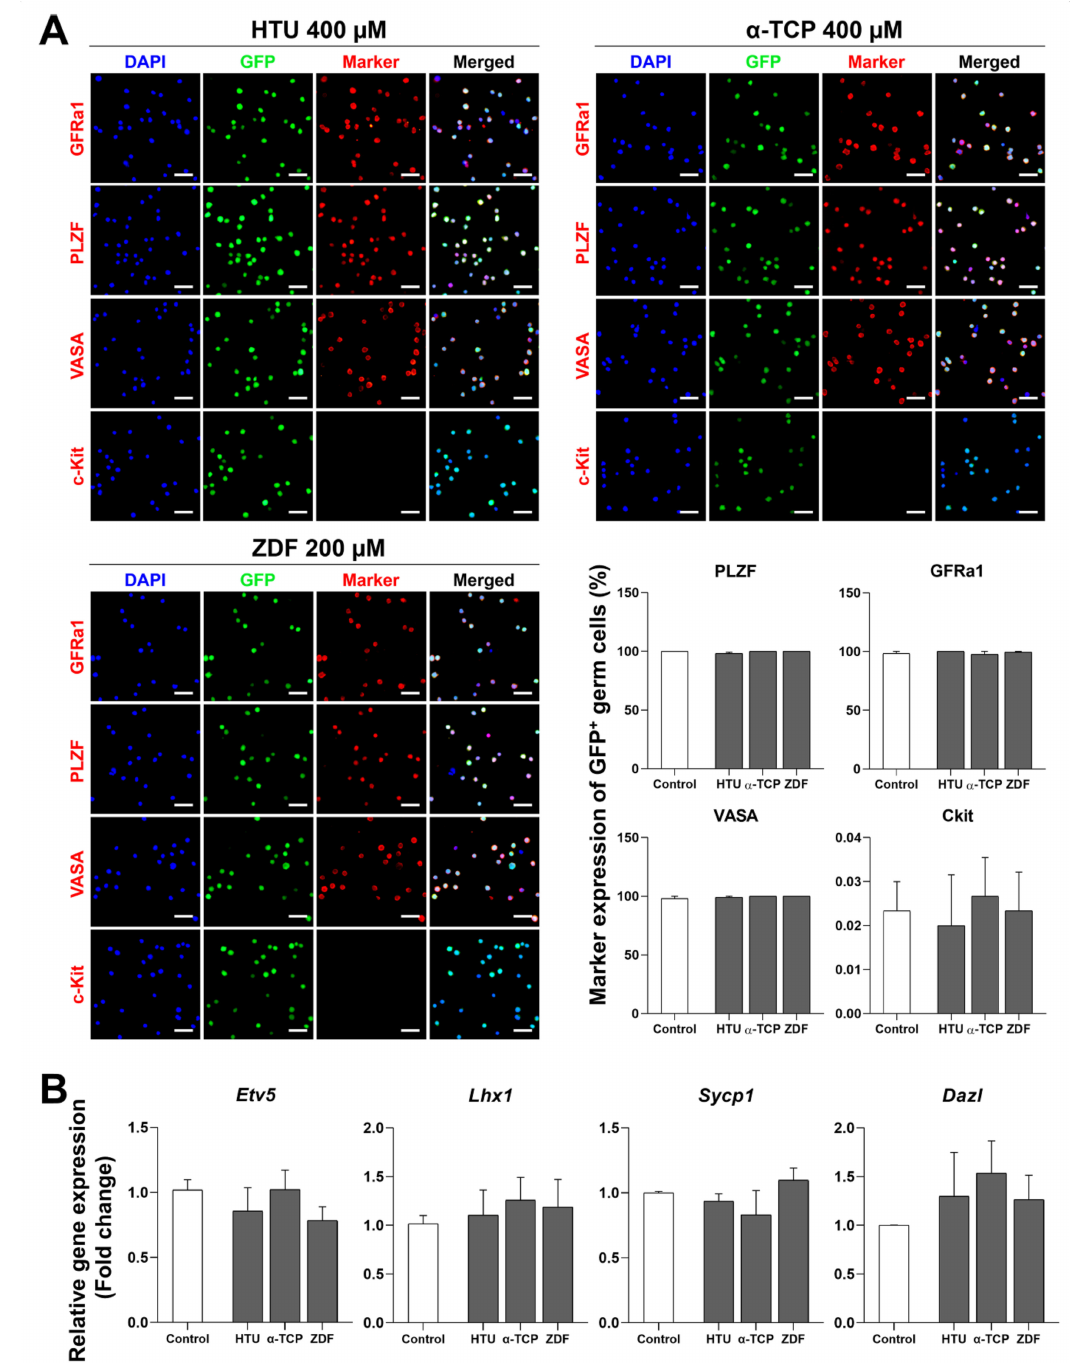
Figure 4. Characterization of germ cells after post-thaw recovery with antioxidant or apoptosis inhibitor supplementation. ( A ) Immunofluorescence analysis of GFP + germ cells after post-thaw recovery in the HTU 400 µ M, α -TCP 400 µ M, and ZDF 200 µ M treatment groups. Representative images obtained after immunofluorescence analyses using markers (shown in red) for undifferentiated spermatogonia (GFR α 1 and PLZF), germ cells (VASA), and differentiated spermatogonia (c-Kit). Nuclei are labeled with DAPI (blue). Scale bar = 100 µ m (40 × ). Marker expression in GFP + GSCs is summarized as a bar graph. ( B ) Relative gene levels of germ cells after post-thaw recovery. Genes for undifferentiated spermatogonia ( Etv5 and Lhx1 ) and differentiated spermatogonia ( Sycp1 and Dazl ) are shown in relative graphical data. Values are expressed as the mean ± SEM ( n = 3). Statistical analysis was performed by one-way ANOVA with Tukey’s test as a post-hoc test. HTU, Hypotaurine; α -TCP, α -tocopherol; ZDF,